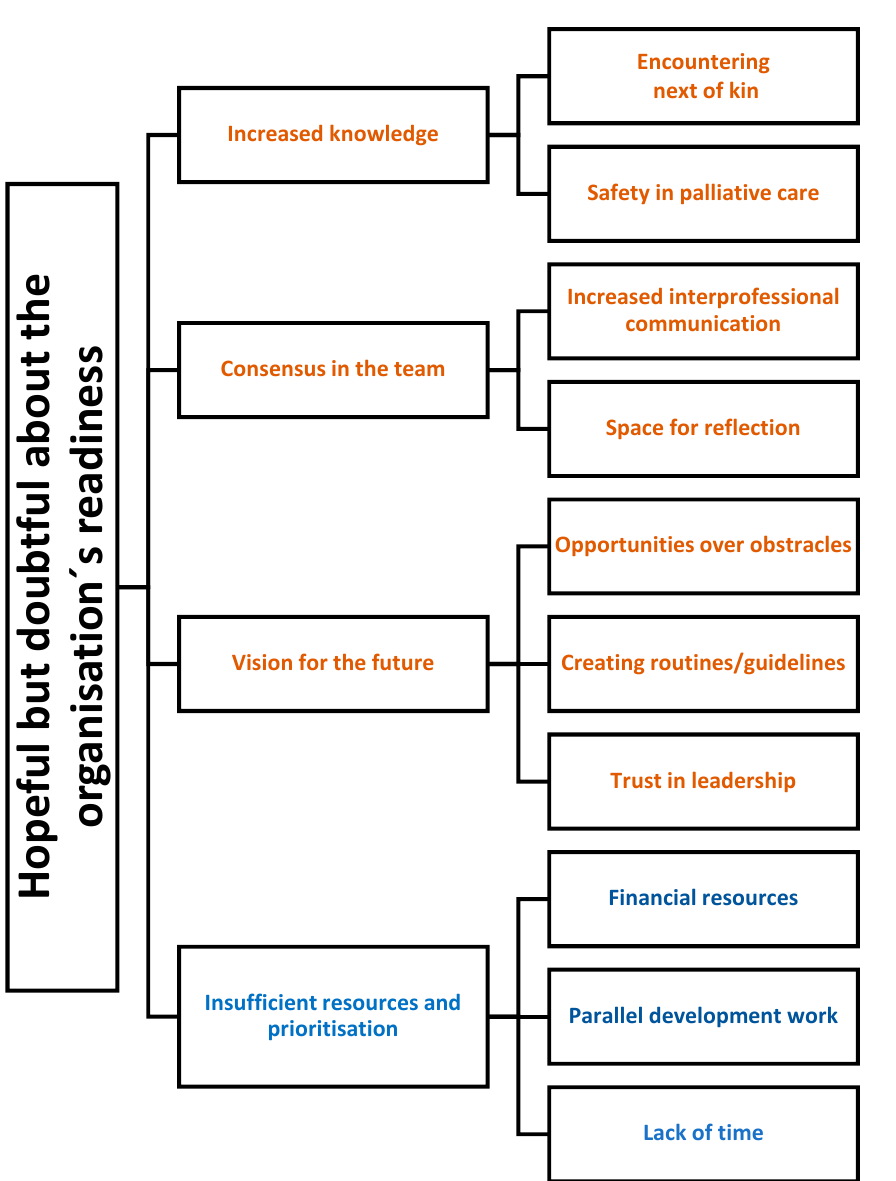
Figure 1. The results, as described in a theme, main categories, and subcategories. The main categories in brown are connected with hope and those in blue with doubts about the organisation’s